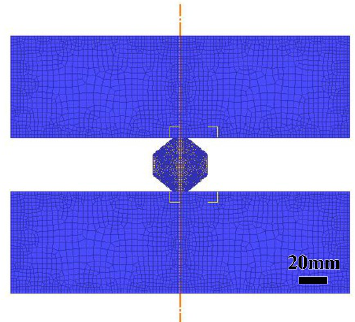
Figure 2. Finite element model of double cone compression tests.